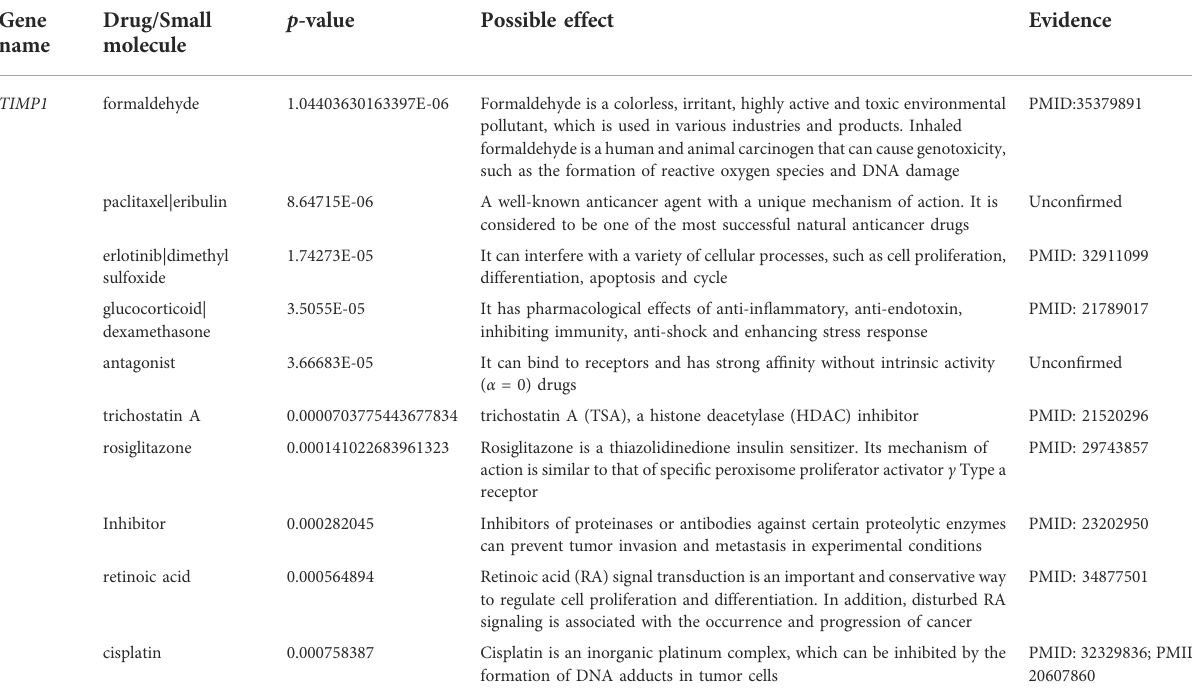
TABLE 2 Top 10 drugs for TIMP1 that were signi fi cantly associated with survival rate of CRC